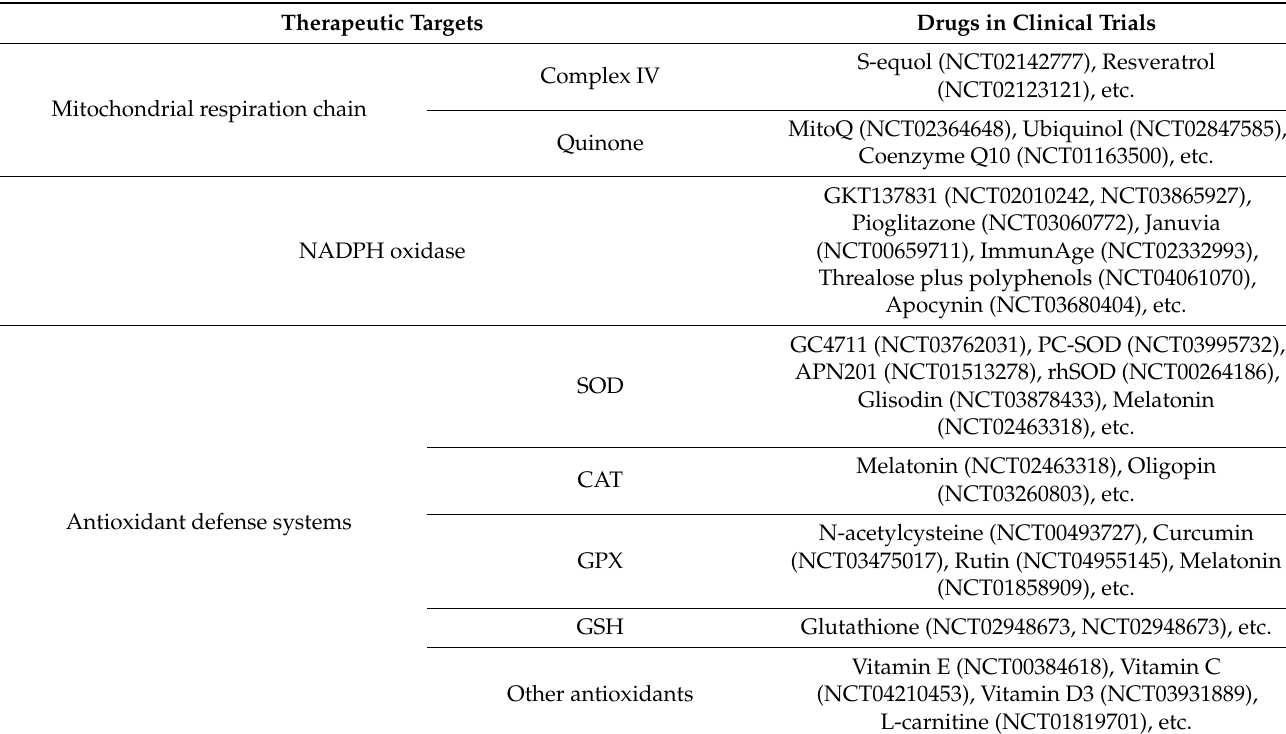
Table 3. A summary of drugs targeting oxidative stress in clinical